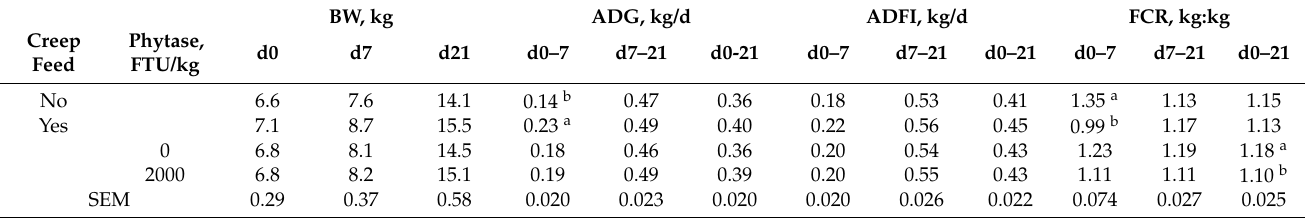
Figure 1. Effect of creep feed on post-weaning cumulative intake of starter diets over 24 h from arrival on site. Data represent means of eight replicate pens per treatment group (creep and no creep). Table 2. Effect of creep feed and phytase on weaning pig performance 1